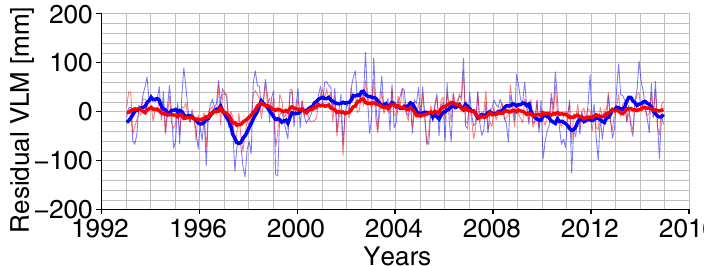
Figure 1. Time series of ALT–TG differenced VLM at Winter Harbour. After averaging or weighting with the correlation a moving-average filter is applied to visualize the remaining interannual variability. In blue: without a threshold on the correlation and without correlation weighting. In red: with a threshold of 0.7 for the correlation and with correlation weighting. In the background are the time series without the moving-average filter applied.